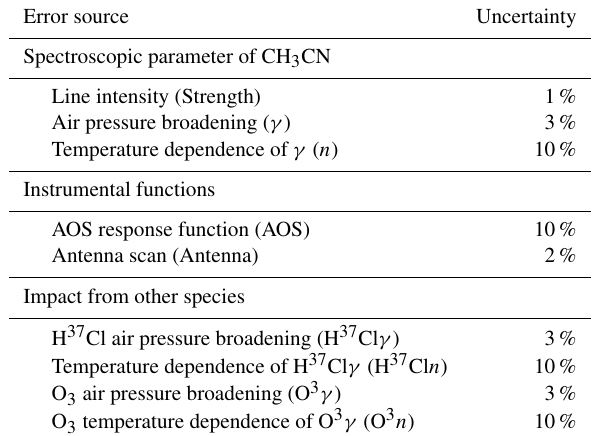
Figure 3. (a) Vertical profile of CH 3 CN retrieved from a single spectral scan on 4 November 2009, in the tropics at a latitude of less than 20 ◦ . (b) The averaging kernel by altitude, for each measure- ment (colored lines), and the measurement response (solid black line). (c) The vertical resolution of the profile, defined as the full width at half maximum (FWHM).